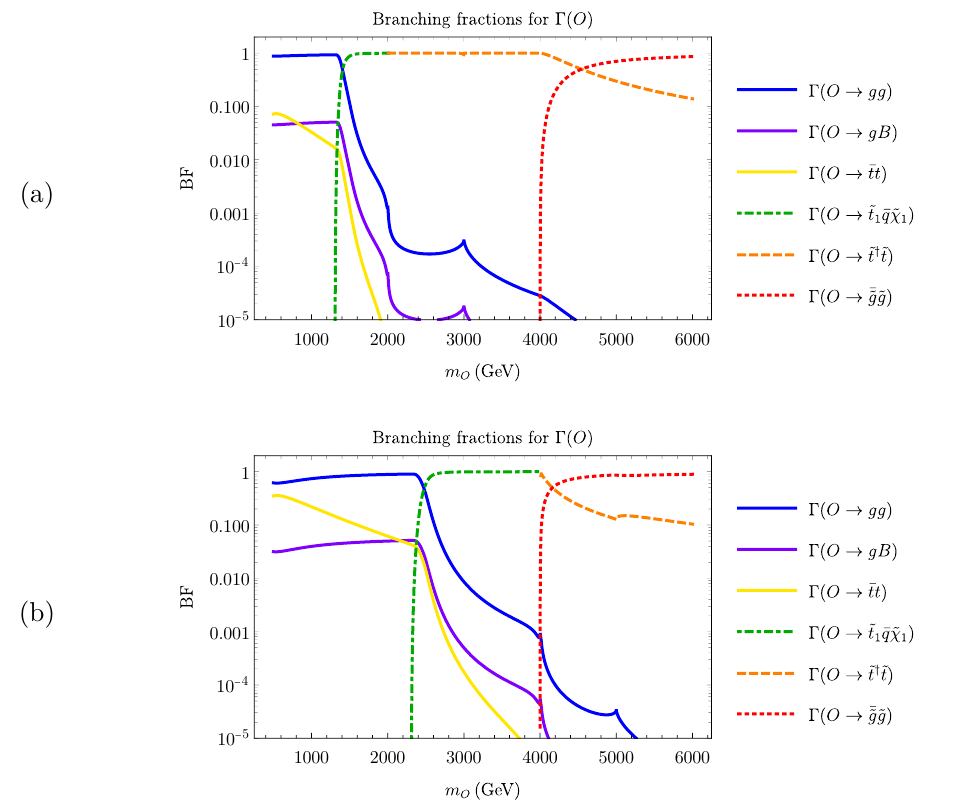
Figure 6. Branching fractions for the scalar sgluon in (a) a modi(cid:12)ed B1 with m 3 = 2.0 TeV and (b)